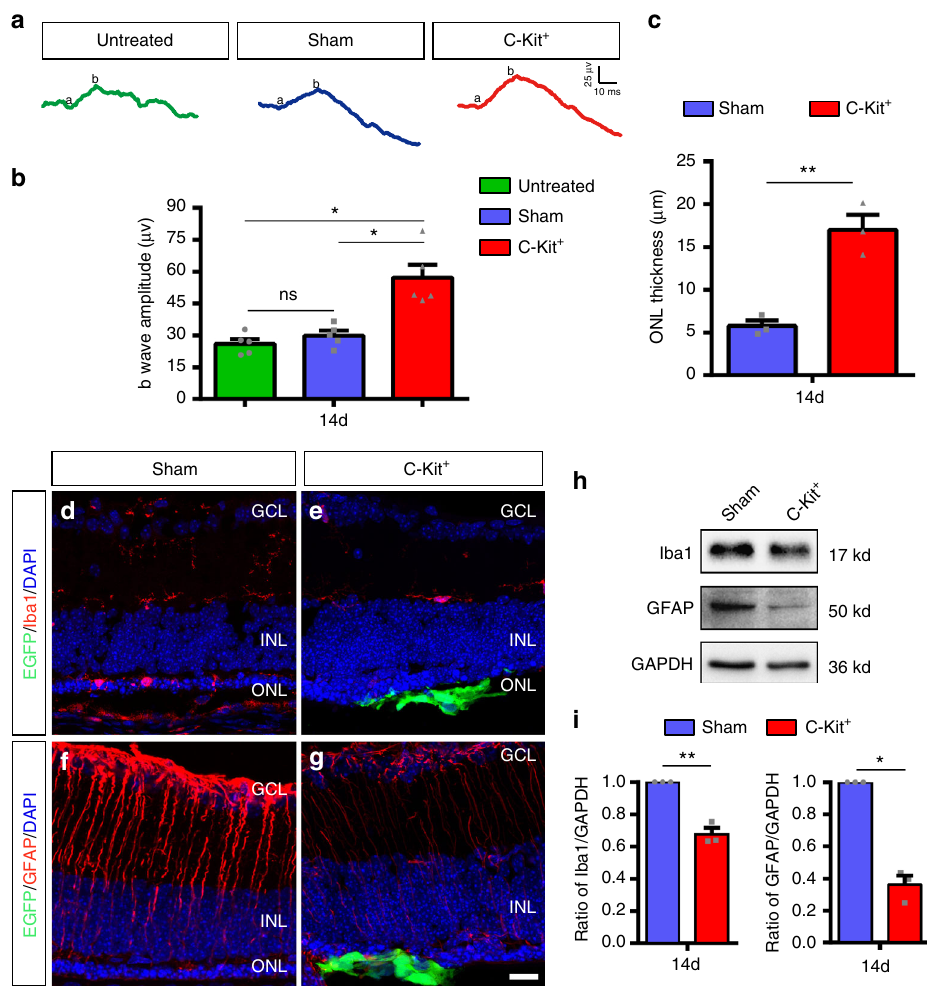
Fig. 8 Improvement of retinal function and microenvironment by C-Kit + cell in rd1 mice. a Representative b-waves of the C-Kit + , sham, and untreated groups of rd1 mice at PO 14d. b Statistical analysis of the amplitude of ERG b-waves in the C-Kit + , sham, and untreated groups at PO 14d ( n = 5 eyes/ group). c Statistical analysis of ONL thickness at PO 14d ( n = 3 eyes/group). d , e Iba1 staining at PO 14d. f , g GFAP staining at PO 14d. Scale bar, 20 μ m. h , i Western blot analysis of Iba1 and GFAP protein levels ( n = 3 eyes/group). P values were determined by one-way ANOVA followed by Dunnett ’ s T3 multiple comparison tests ( b ) * P < 0.05; ** P < 0.01; *** P < 0.001, ns not signi fi cant. P values were determined by unpaired two-tailed Student ’ s t -test ( c , i ) * P < 0.05; ** P < 0.01; *** P < 0.001. Data are presented as mean ±